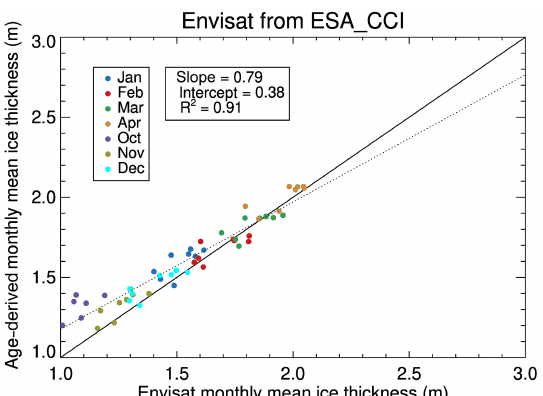
Figure 10. Scatterplot of IceAgeDerived and Envisat monthly mean ice thickness, where Envisat data are from ESA CCI. The dashed line represents the regression line of IceAgeDerived monthly mean ice thickness on the Envisat data, with the slope, intercept, and R 2 indicated.